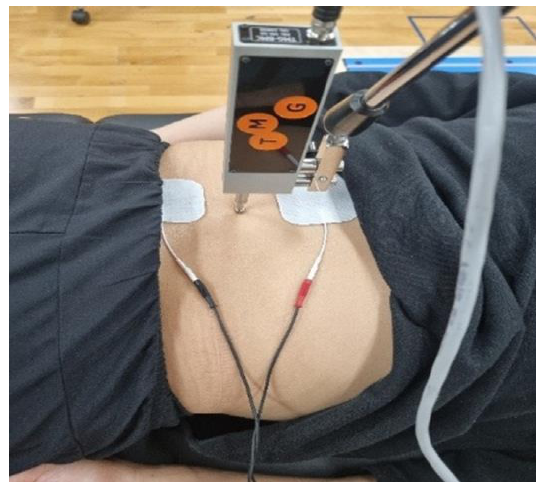
Figure 1. Measurement position of TMG.